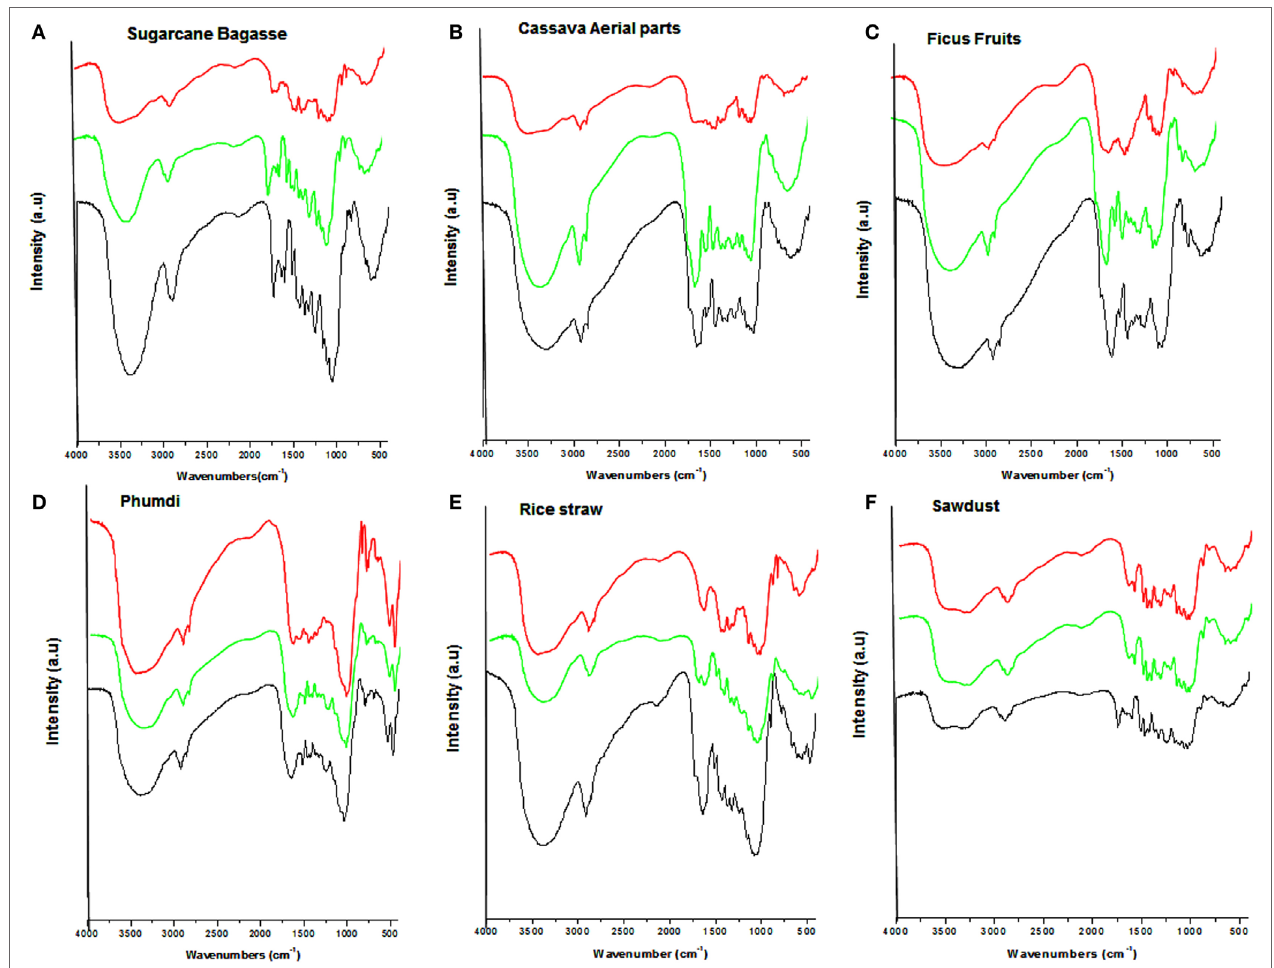
FigUre 2 | Fourier transform infrared spectra of six types of lignocellulosic biomass. The red, green, and black lines indicate sodium hydroxide treated, hydrothermally treated, and untreated, respectively. (a) Sugarcane bagasse, (B) cassava aerial parts, (c) ficus fruits, (D) Phumdi , (e) rice straw, and (F)